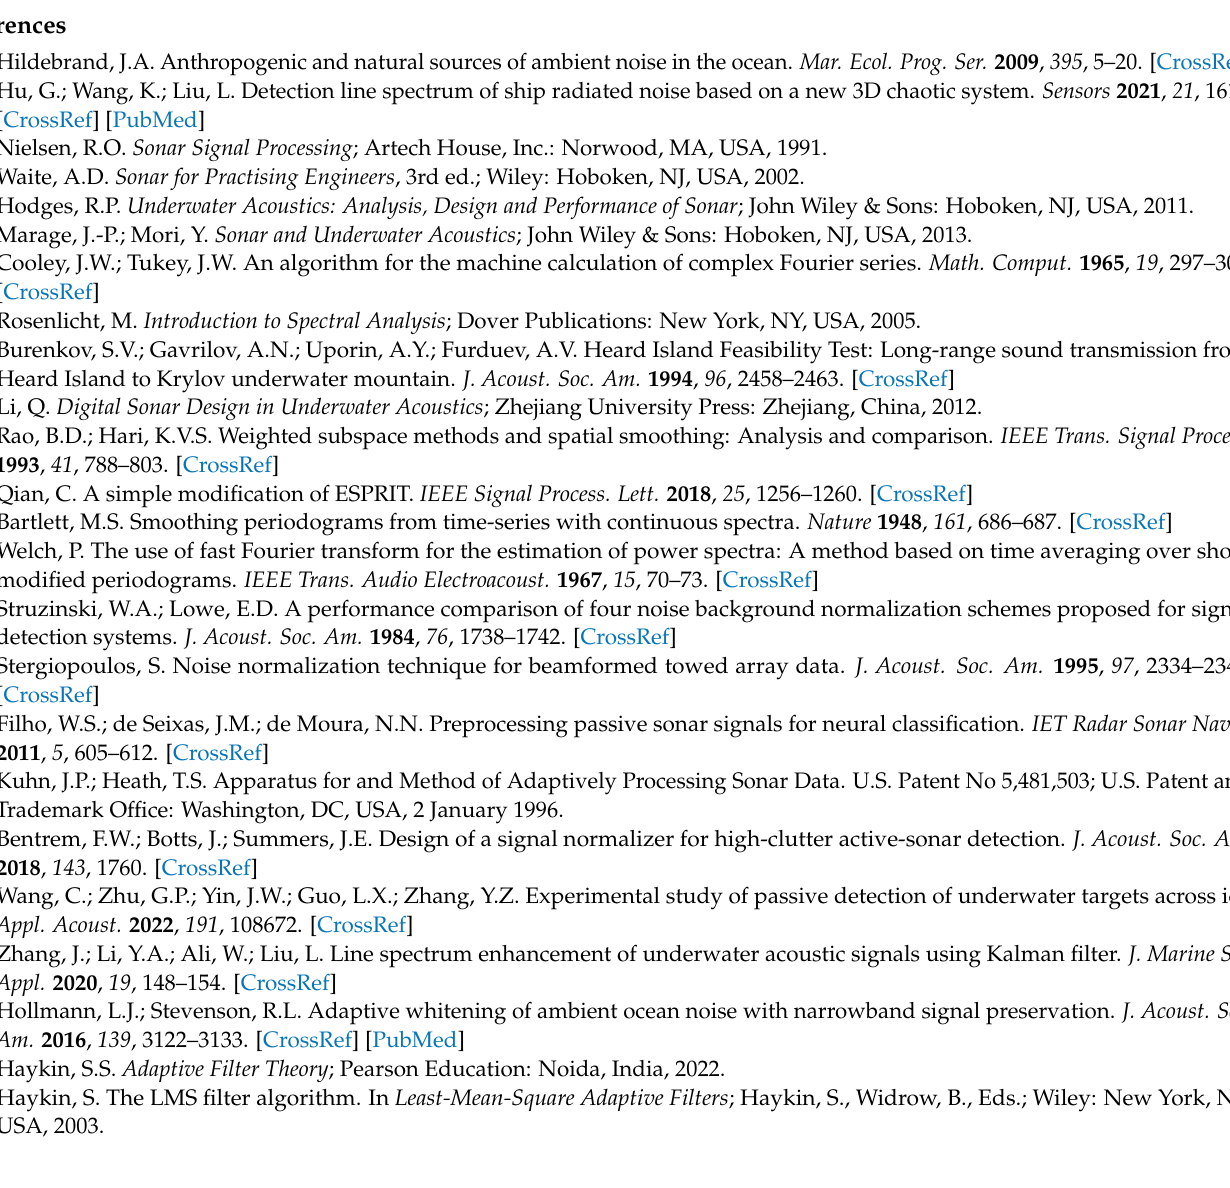
Figure A2. Schematic diagram of the calculation method for the in ‐ band SNR.